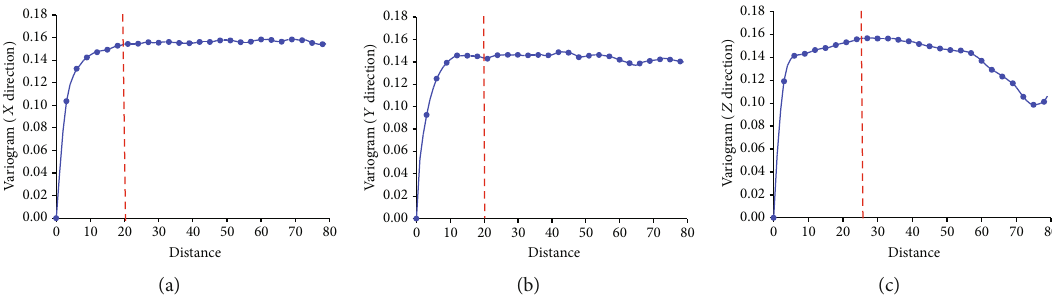
Figure 13: Variogram curves of original volume data (sandstone) in three directions: (a) X direction; (b) Y direction; (c) Z direction.